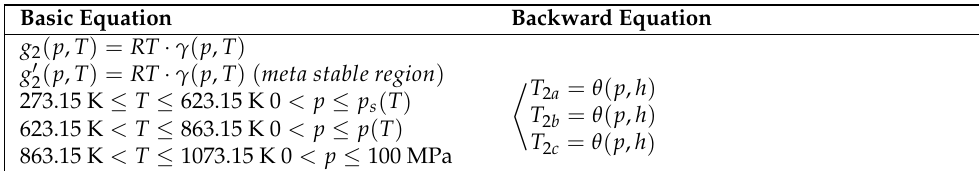
Table 3. Relations for region 2 in